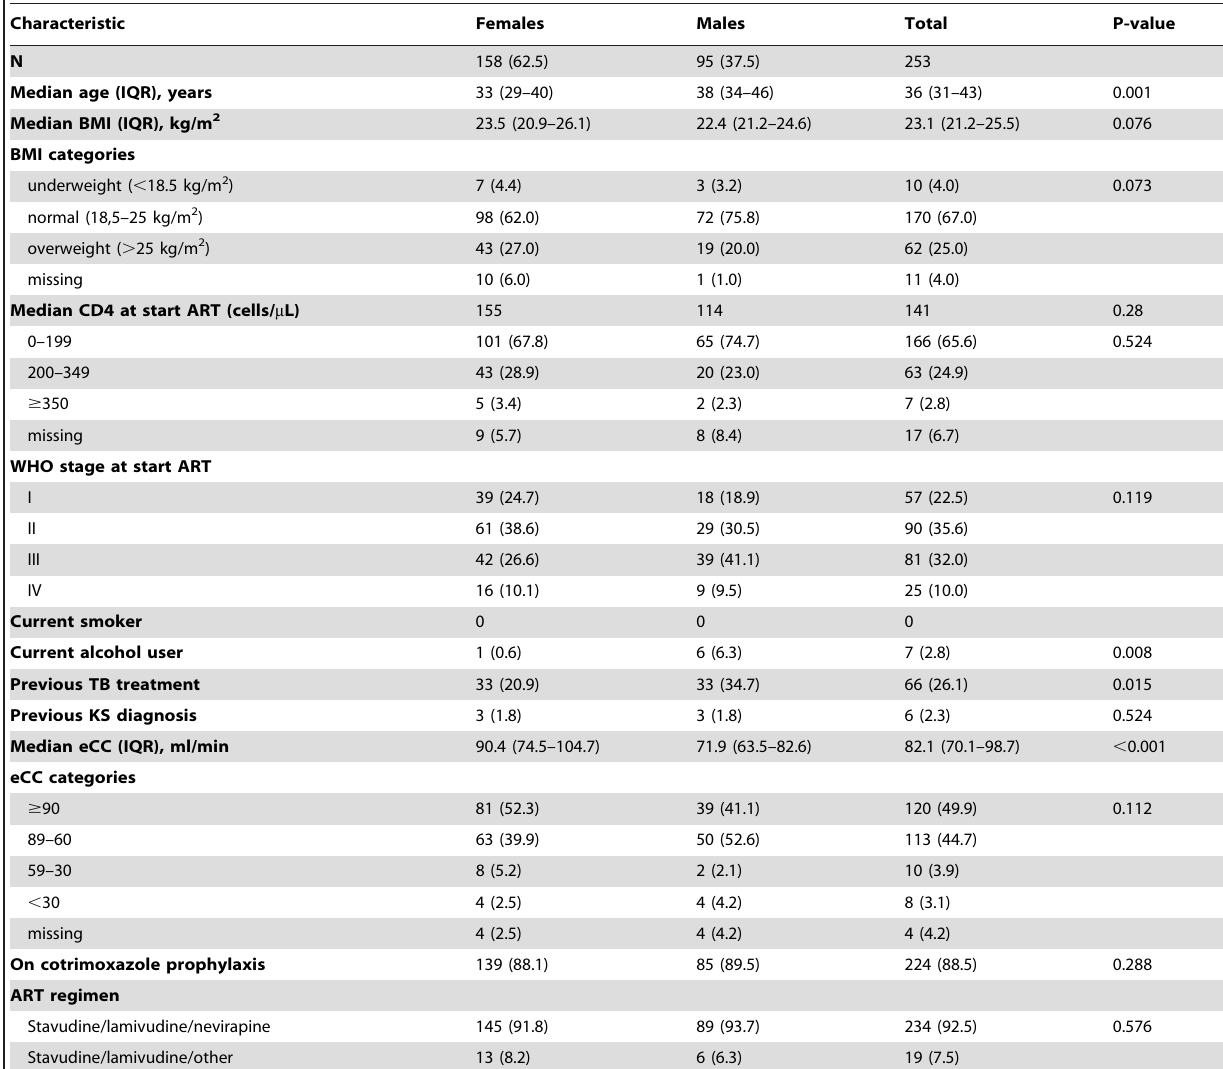
Table 1. Patient